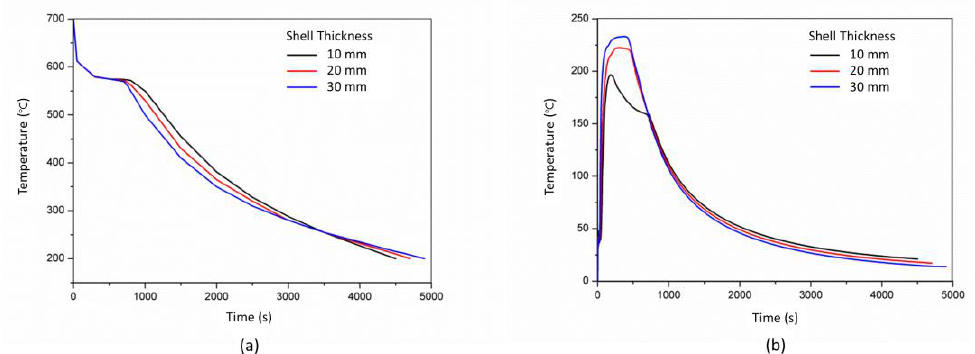
Figure 21. Comparison of cooling curves of P3 in the casting using the skeletal sand mold with different shell thicknesses: (a) cooling curves and (b) temperature difference between thick and thin bars (P1 and P2) .